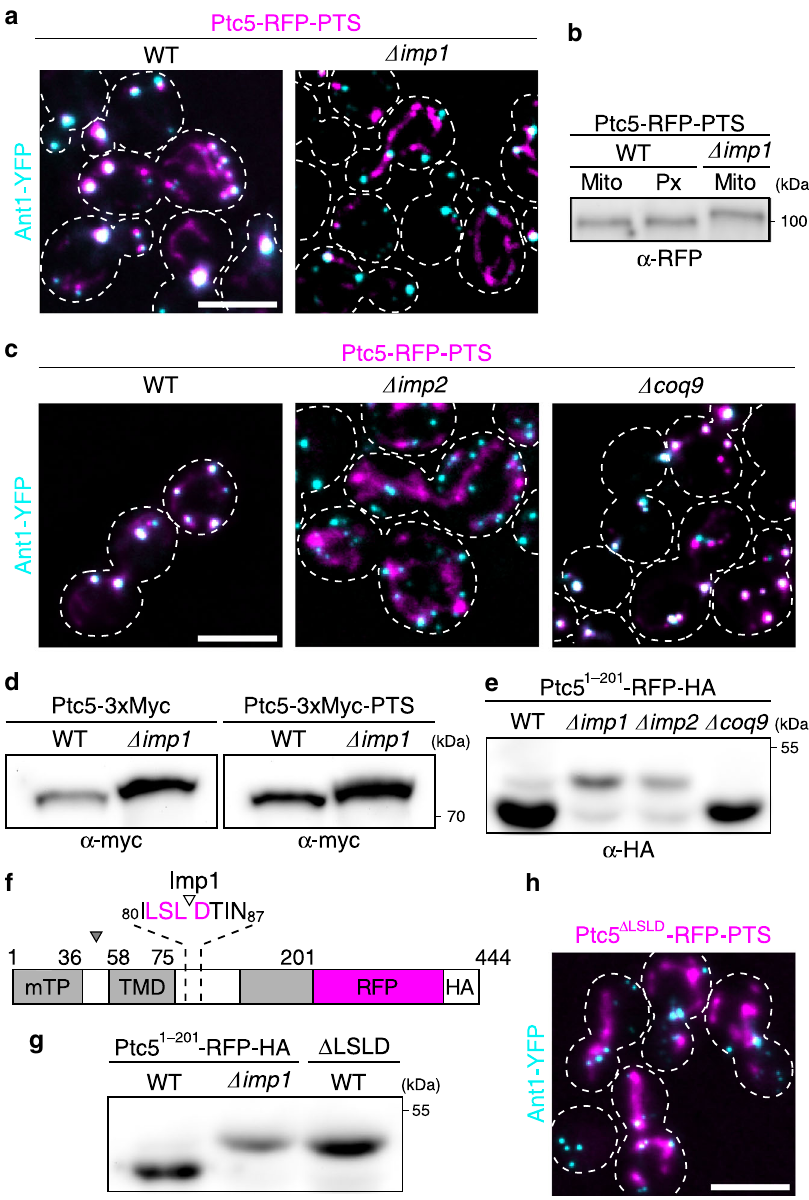
Fig. 3 Ptc5 transits mitochondria en route to peroxisomes. a Intracellular localization of Ptc5-RFP-PTS (magenta) and Ant1-YFP (cyan) in WT and Δ imp1 cells. White color indicates colocalization. Scale bar represents 5 µ m. b Ptc5-RFP-PTS in mitochondrial (Mito) and peroxisomal (Px) fractions derived from gradient centrifugation (Supplementary Fig. 2a) was detected by western blot. A mitochondrial fraction (Supplementary Fig. 2a) from Δ imp1 cells was analyzed to detect unprocessed Ptc5-RFP-PTS. c Localization of Ptc5-RFP-PTS (magenta) was investigated by fl uorescence microscopy in indicated strains. Ant1-YFP (cyan) served as marker for peroxisomes. White color indicates colocalization. Scale bar represents 5 µ m. d Migration of Ptc5-3xMyc and Ptc5- 3xMyc-PTS isolated from WT, and Δ imp1 cells was investigated using SDS – PAGE and western blot. e The truncated Ptc5 variant Ptc5 1 – 201 -RFP-HA from indicated strainswas analyzed by SDS – PAGE and western blot. Truncation increased resolution between higher and lower mobility bands. f Schematic representation of the Imp1 cleavage site in Ptc5 1 – 201 -RFP-HA as identi fi ed by mass spectrometry (see Supplementary Table. 1). The cleavage site is located between amino acid residue 83 and 84. g Processing of Ptc5 1 – 201 -RFP-HA was analyzed by SDS – PAGE and western blot. Δ LSLD refers to a construct derived from Ptc5 1 – 201 -RFP-HA lacking the amino acids surrounding the cleavage site (see Fig. 2f). h Intracellular localization of Ptc5 Δ LSLD -RFP-PTS and Ant1-YFP. White color indicates colocalization. Scale bar represents 5 µ m. Source data are provided in the Source data fi